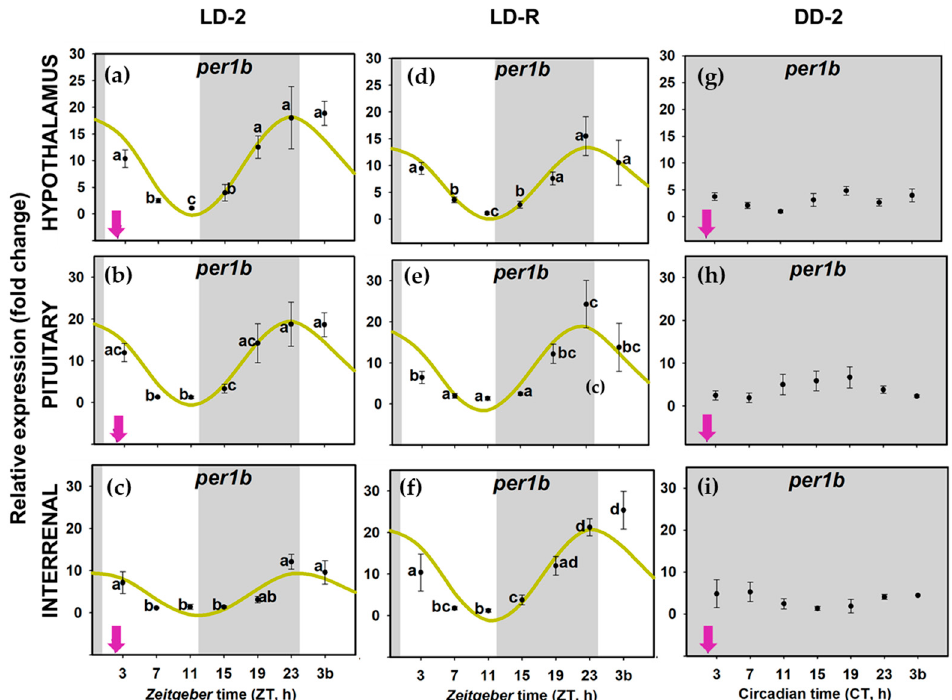
Figure 5. Relative expression of per1b in hypothalamus ( a , d , g ), pituitary ( b , e , h ) and interrenal tissue ( c , f , i ) of goldfish. Data are expressed as mean ± standard error ( n = 8). Grey areas indicate the darkness period, and arrows point to the feeding time when it was scheduled (ZT 2). Different letters show significant differences among groups (ANOVA and SNK test). The curves show sinusoidal periodic functions obtained by cosinor analysis when it was significant (noise/signal < 0.3).